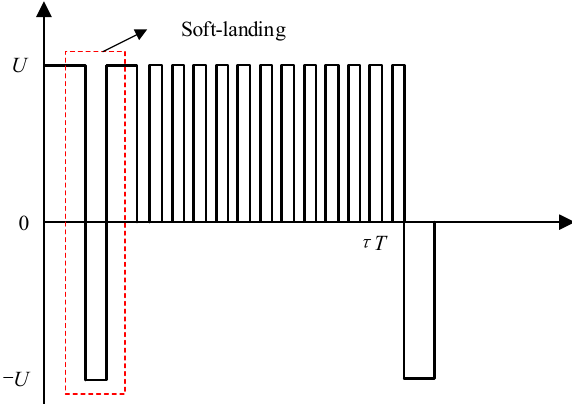
Figure 12. Schematic diagram of soft-landing PWM control signal.